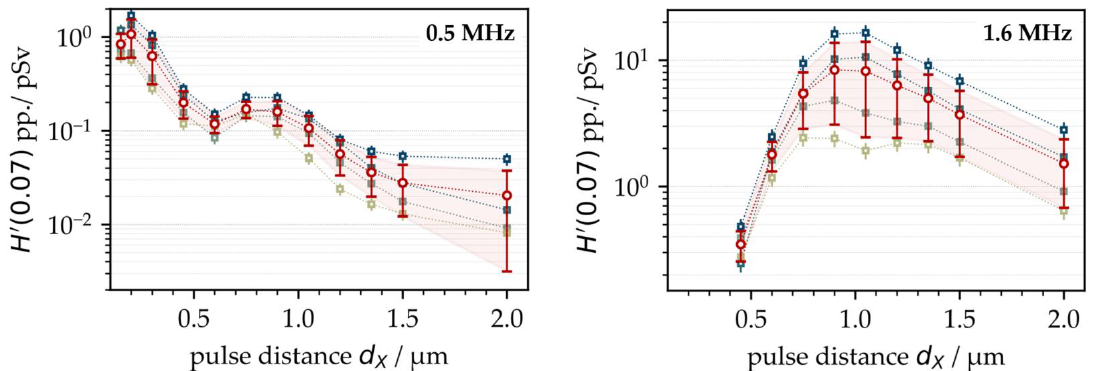
Figure 1. X-ray emission dose per pulse as a function of the intra-line pulse distance at 0.5 MHz ( left ) and 1.6 MHz ( right ) PRF obtained on 4 different days. The mean values are highlighted by the red symbols (circles).